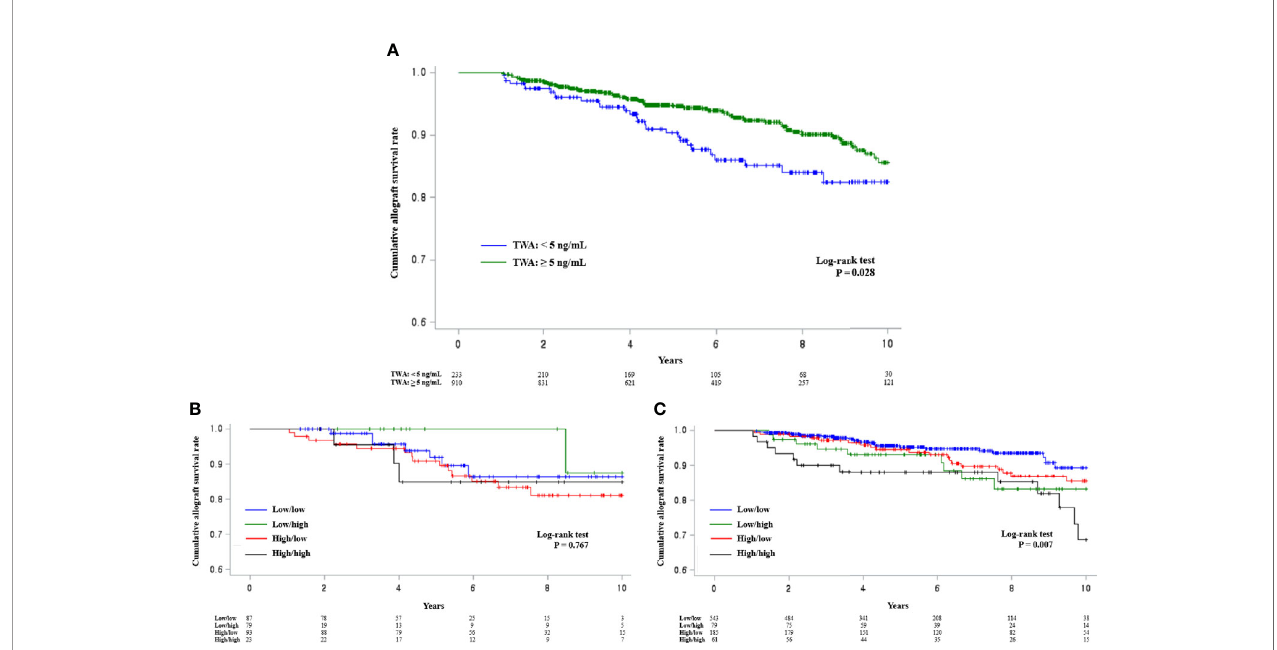
FIGURE 3 | Kaplan – Meier survival analysis of allograft survival according to TAC-C0-TWA and TAC-C0-TWCV during post-transplant 0 – 1 st and 1 st – 2 nd years. (A) The group with a TAC-C0-TWA of <5 ng/ml had a lower cumulative allograft survival rate than the group with a TAC-C0-TWA of ≥ 5 ng/ml. (B) The cumulative allograft survival rates did not differ among the groups in the subgroup with a TAC-C0-TWA of <5 ng/ml. (C) The high/high group in the subgroup with a TWA of ≥ 5 ng/ml had the lowest cumulative allograft survival rate. These fi ndings were similar to those of the entire patient cohort. TAC-C0, tacrolimus trough level; TWA, time- weighted average; TWCV, time-weighted coef fi cient